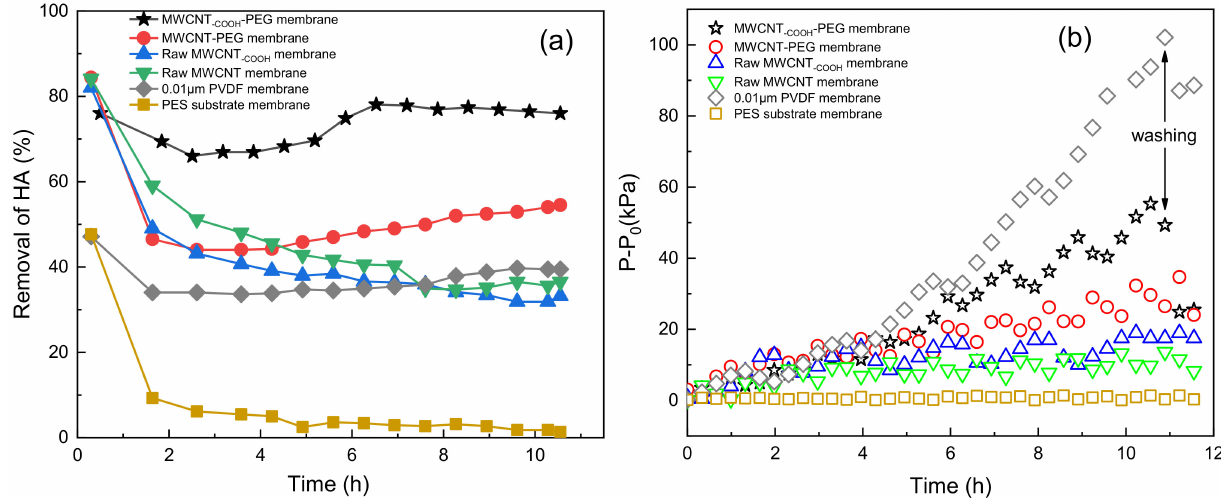
Figure 10. Effects of modified membrane on HA fouling: ( a ) HA removal rate graph; ( b ) P-P 0